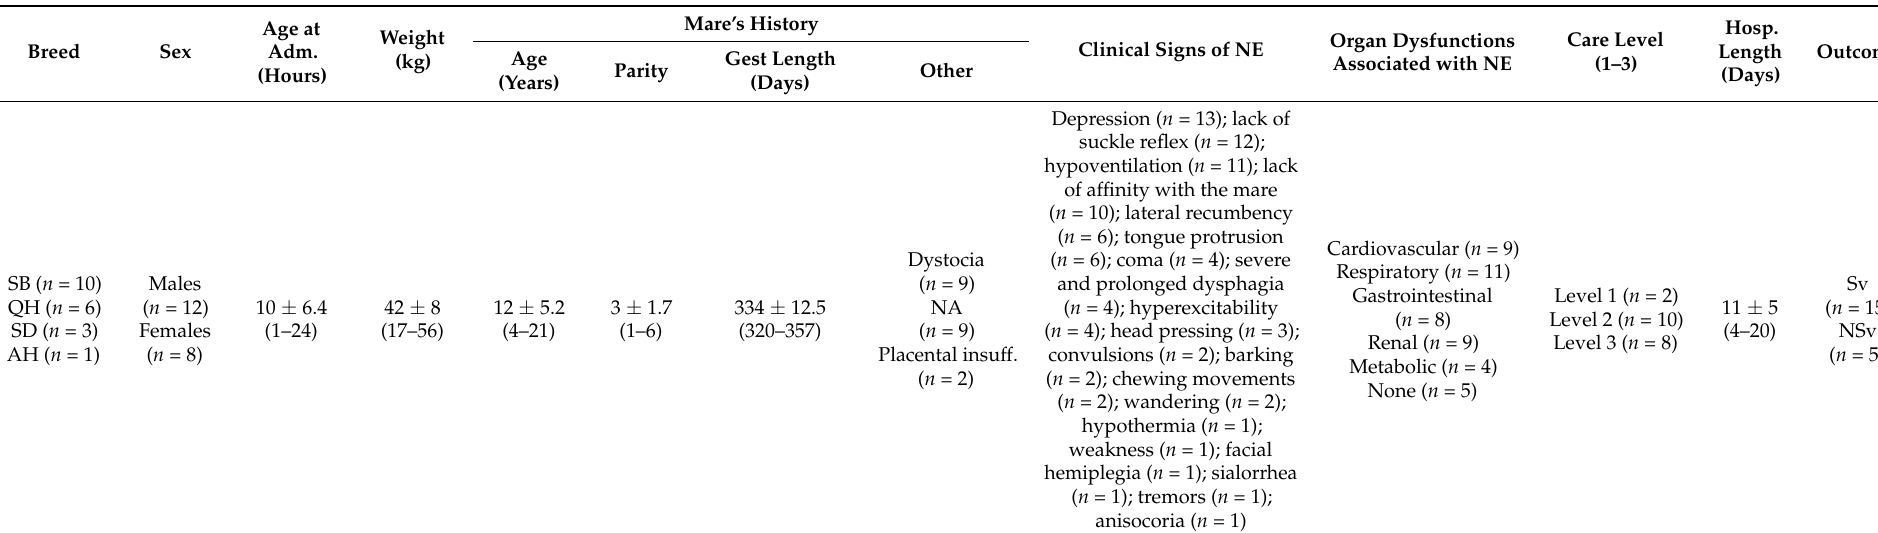
Table 4. Clinical data collected from 20 foals affected by Neonatal Encephalopathy hospitalized within 24 h after birth (group exNE). SB = Standardbred; QH = Quarter Horse; SD = Saddlebred; AH = Arabian Horse; Sv = survived to hospital discharge; NSv = not survived; NA = data not available; n = number of animals. Data are expressed as mean ± standard deviation